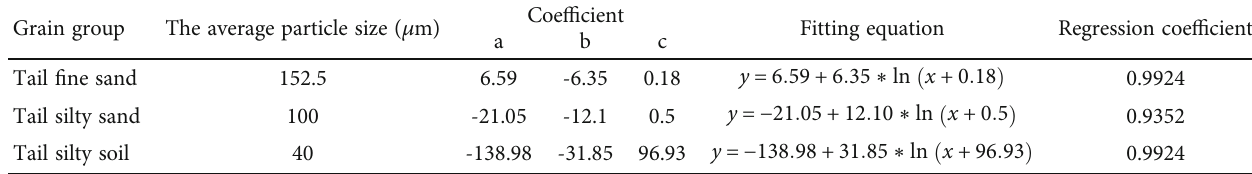
Table 3: Capillary water height fi tting equations for tailings with di ff erent particle